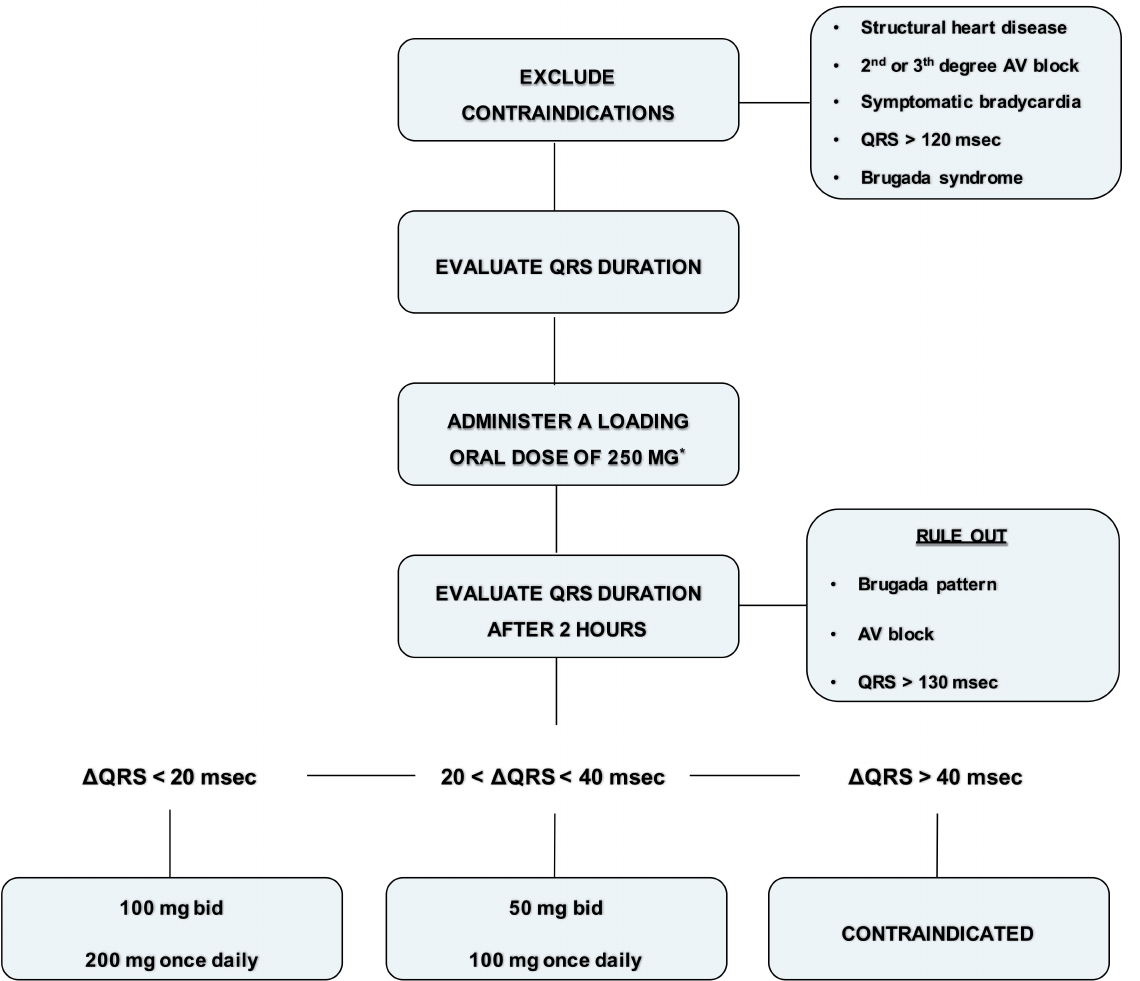
Figure 2. Flowchart for administration of flecainide. * Loading oral dose of 200 mg is recommended if the weight is lower than 70 kg.